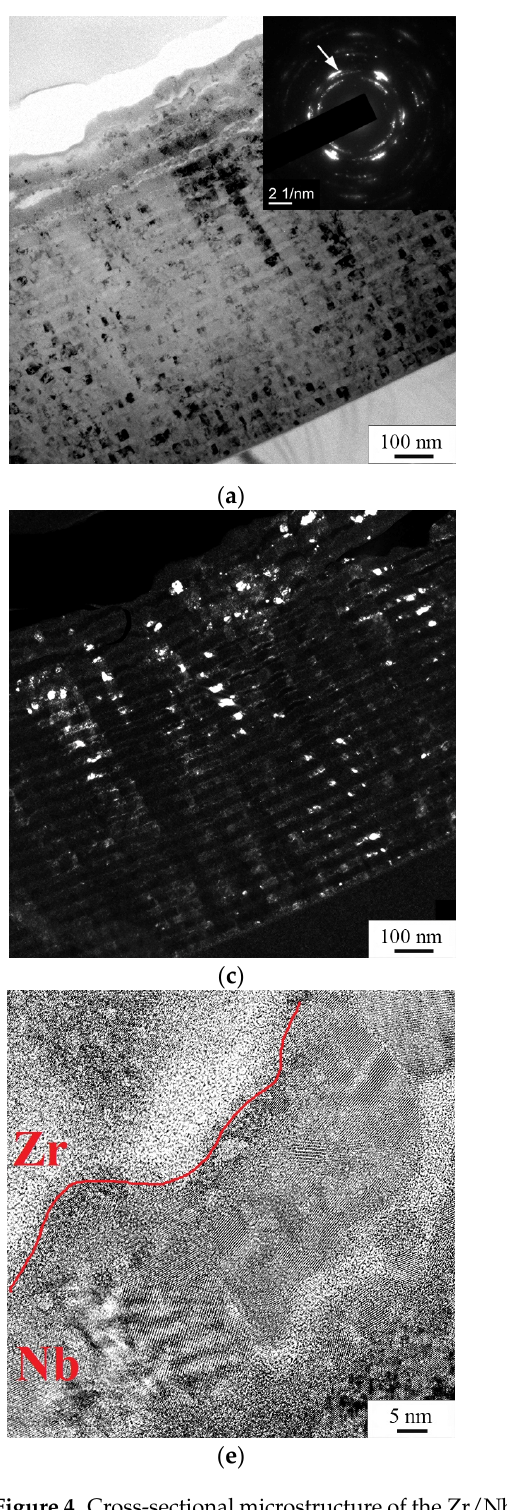
Figure 4. Cross-sectional microstructure of the Zr/Nb 25/25 ( a , c , e ) and Zr/Nb 100/100 ( b , d , f ) NMCs after irradiation with helium ions with a dose of 2 × 10 17 ions/cm 2 : bright-field images and corresponding SAED ( a , b ), dark-field image in (220) Nb β reflection (indicated by arrow in ( a )) ( c ), dark-field image in (110) Zr α reflection (indicated by arrow in ( b )) ( d ), dark-field image in (110) Zr α reflection (indicated by arrow) ( d ), HR TEM images ( e , f